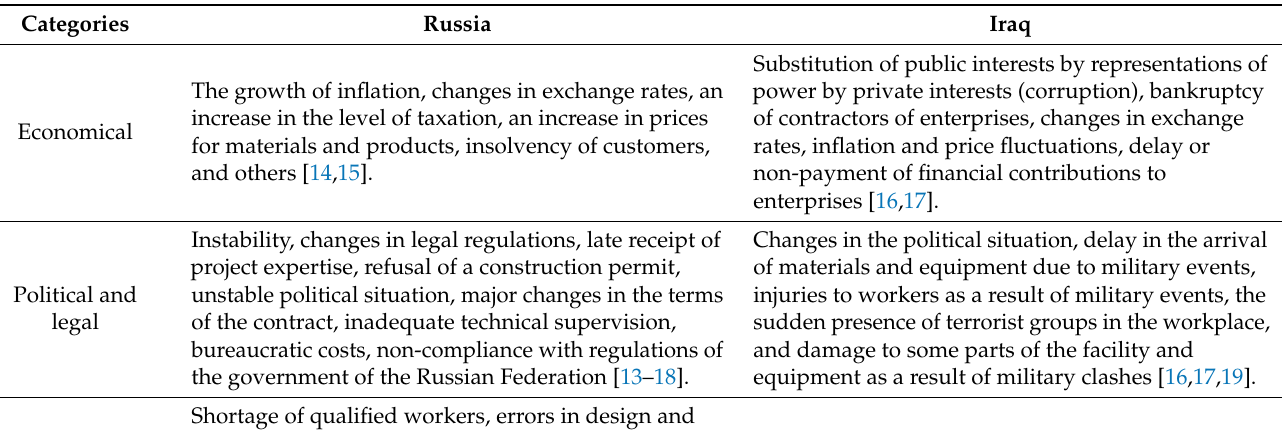
Table 1. Categories of risk factors in construction enterprises.